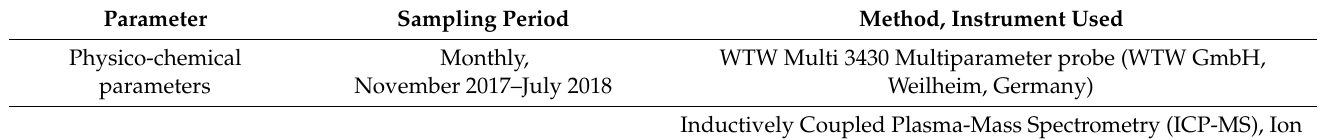
Table 1. Summary list of monitoring parameters, sampling periods, and